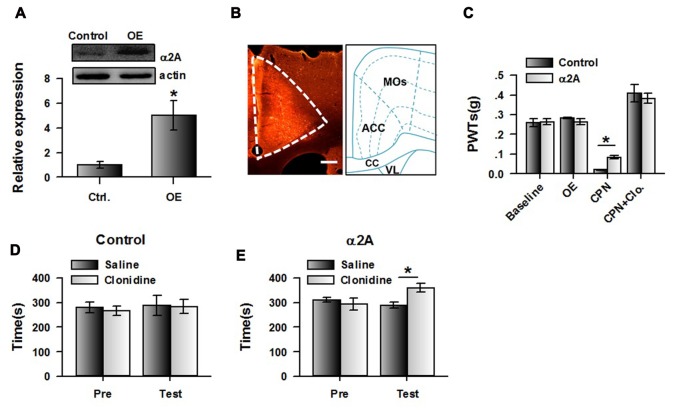
Over-expressing of α2A adrenoceptors alleviated the evoked pain tested at day 14 after CPN. (A) The representative immunoblotting bands (top) and the quantitative data showed that the expression of α2A adrenoceptors was increased in ACC with AAV9-CMV-Adra2a-P2A-mCherry, but not its control. t-test, P < 0.05, n = 4 per group, *P < 0.05. (B) An example of the virus expression in ACC. (C) The PWTs were slightly increased by the overexpressed α2A adrenoceptors in the ACC at day 14 after nerve injury. Two-Way RM ANOVA, control vs. virus: F(1,55) = 0.16, P > 0.05, treatments: F(3,55) = 98.15, P < 0.05, interaction: F(3,55) = 1.83, P > 0.05, n = 6 for control group, n = 8 for α2A virus injection group. *P < 0.05. (D) The mice with the control virus injection did not show the place preference at day 14 after CPN. Two-Way RM ANOVA, Pre vs. Test: F(1,23) = 0.44, P > 0.05, saline vs. clonidine: F(1,23) = 0.04, P > 0.05, interaction: F(1,23) = 0.07, P > 0.05, n = 6. (E) Clonidine (0.5 mg/kg) induced place preference at day 14 after CPN on the mice with over-expressed of α2A adrenoceptors in the ACC. *P < 0.05. Two-Way RM ANOVA, Pre vs. Test: F(1,31) = 4.10, P > 0.05, saline vs. clonidine: F(1,31) = 1.69, P > 0.05, interaction: F(1,31) = 14.92, P < 0.05, n = 8.